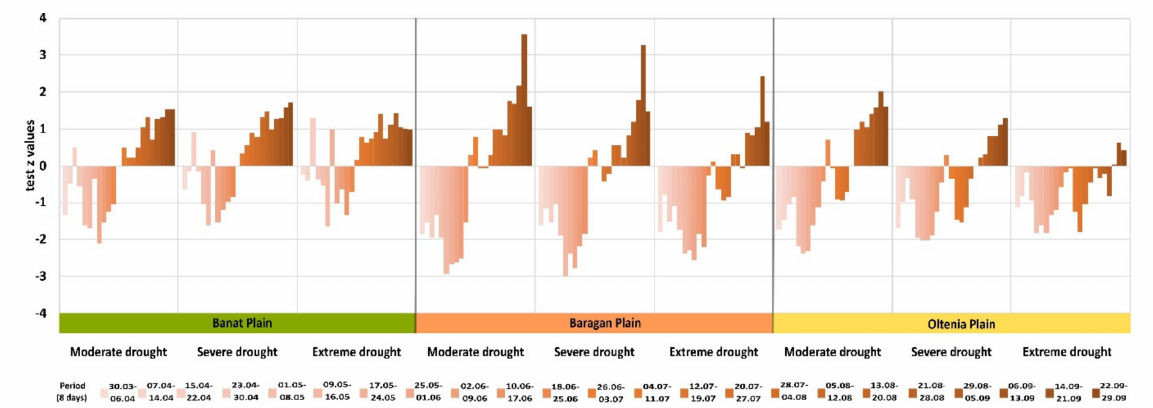
Figure 13. Trend of the agricultural surface a ff ected by DSI according to the Mann-Kendall test